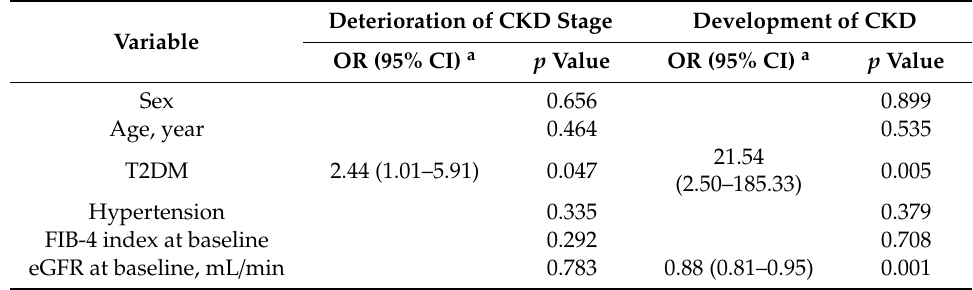
Table 4. Factors associated with deterioration of chronic kidney disease and incidence of chronic kidney disease in patients with non-alcoholic fatty liver disease in the follow-up cohort identified by multivariate